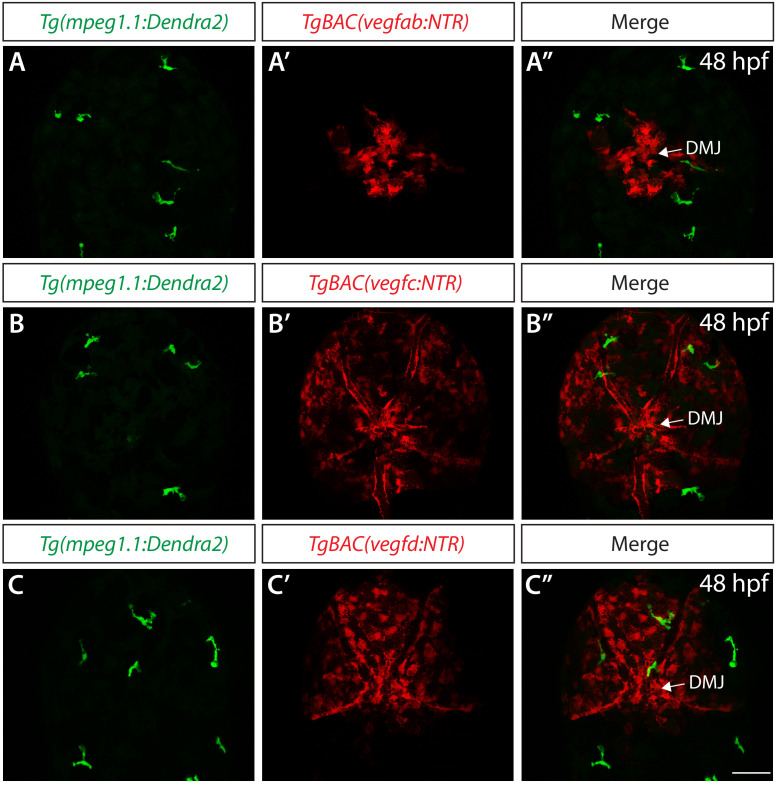
Co-localization analyses in TgBAC(vegfab:NTR), TgBAC(vegfc:NTR), and TgBAC(vegfd:NTR) embryos carrying the Tg(mpeg1.1:Dendra2) transgene.(A–A") Confocal maximum projection images of the dorsal views of a 48 hpf Tg(mpeg1.1:Dendra2);TgBAC(vegfab:NTR) embryo, showing non-overlapping distribution of EGFP+ and NTR-mCherry+ meningeal cells (n = 16 embryos; 89 Tg(mpeg1.1:Dendra2)+ cells examined; 0 cells co-localized with TgBAC(vegfab:NTR)+ cells). (B–B") Confocal maximum projection images of the dorsal views of a 48 hpf Tg(mpeg1.1:Dendra2);TgBAC(vegfc:NTR) embryo, showing non-overlapping distribution of EGFP+ and NTR-mCherry+ meningeal cells (n = 17 embryos; 95 Tg(mpeg1.1:Dendra2)+ cells examined; 0 cells co-localized with TgBAC(vegfc:NTR)+ cells). (C–C") Confocal maximum projection images of the dorsal views of a 48 hpf Tg(mpeg1.1:Dendra2);TgBAC(vegfd:NTR) embryo, showing non-overlapping distribution of EGFP+ and NTR-mCherry+ meningeal cells (n = 8 embryos; 39 Tg(mpeg1.1:Dendra2)+ cells examined; 0 cells co-localized with TgBAC(vegfd:NTR)+ cells). Scale bar: 50 μm.